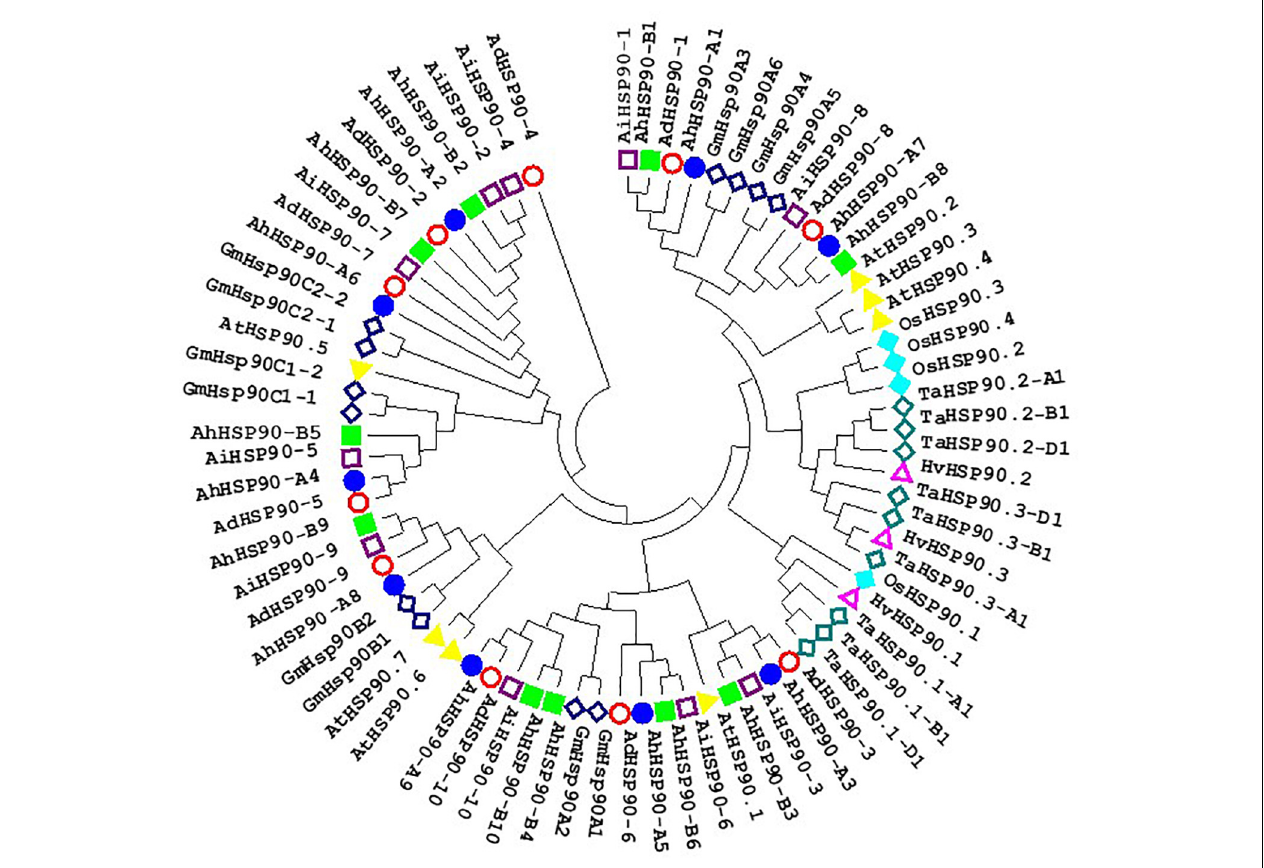
FIGURE 3 | Phylogenetic tree of HSP90 proteins of Arachis , Arabidopsis , rice, soybean, barley, and wheat. Multiple sequence alignment of peanut NAC proteins was performed using ClustalW, and the phylogenetic tree was constructed using MEGA 6.0 by the neighbor-joining method with 1000 bootstrap